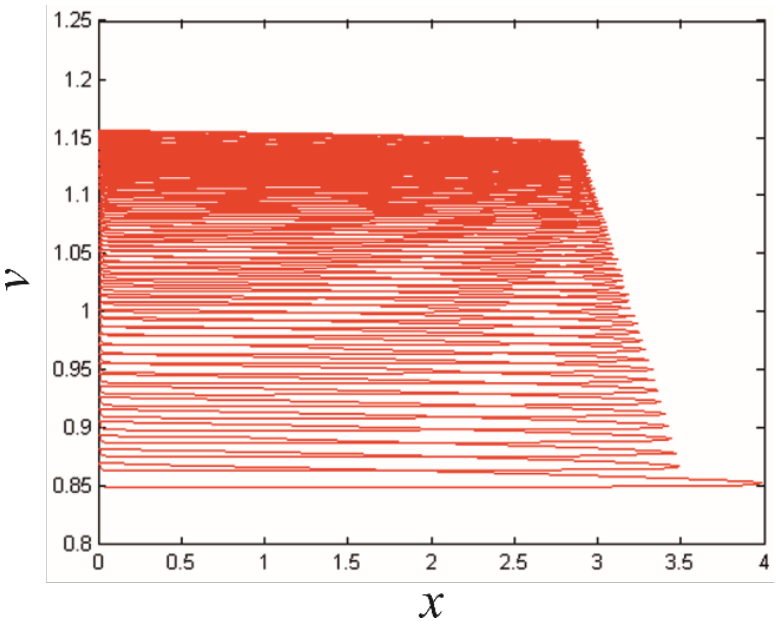
Figure 11. Bidimensional attractor ( x , v ) for high flux in dynamic Györgyi–Field system (α = 3000/9; β = 6/23; C = 0.001; A = 0.14 mol; M = 0.3 mol; H = 0.26 mol and k f = 6.18 × 10 −4 ).